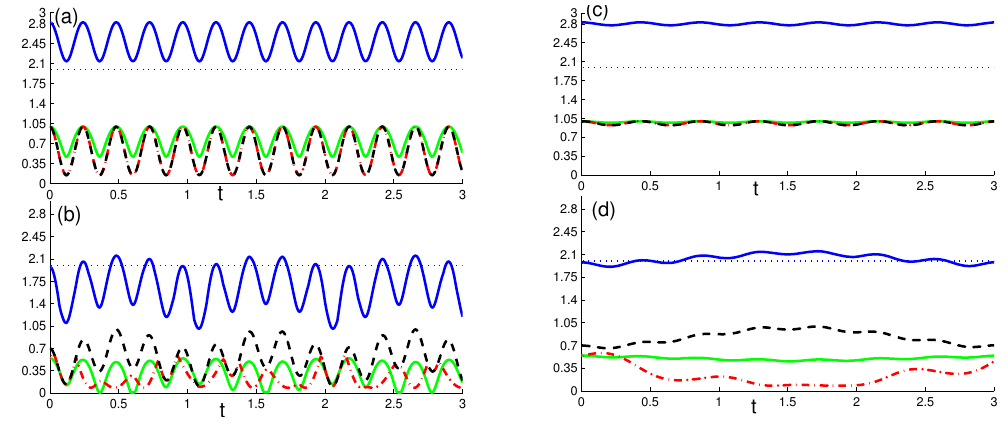
Figure 7. As Figure 6a,b but for χ z = 3 in panels ( a , b ) and ∆ = 0.5 in panels ( c , d